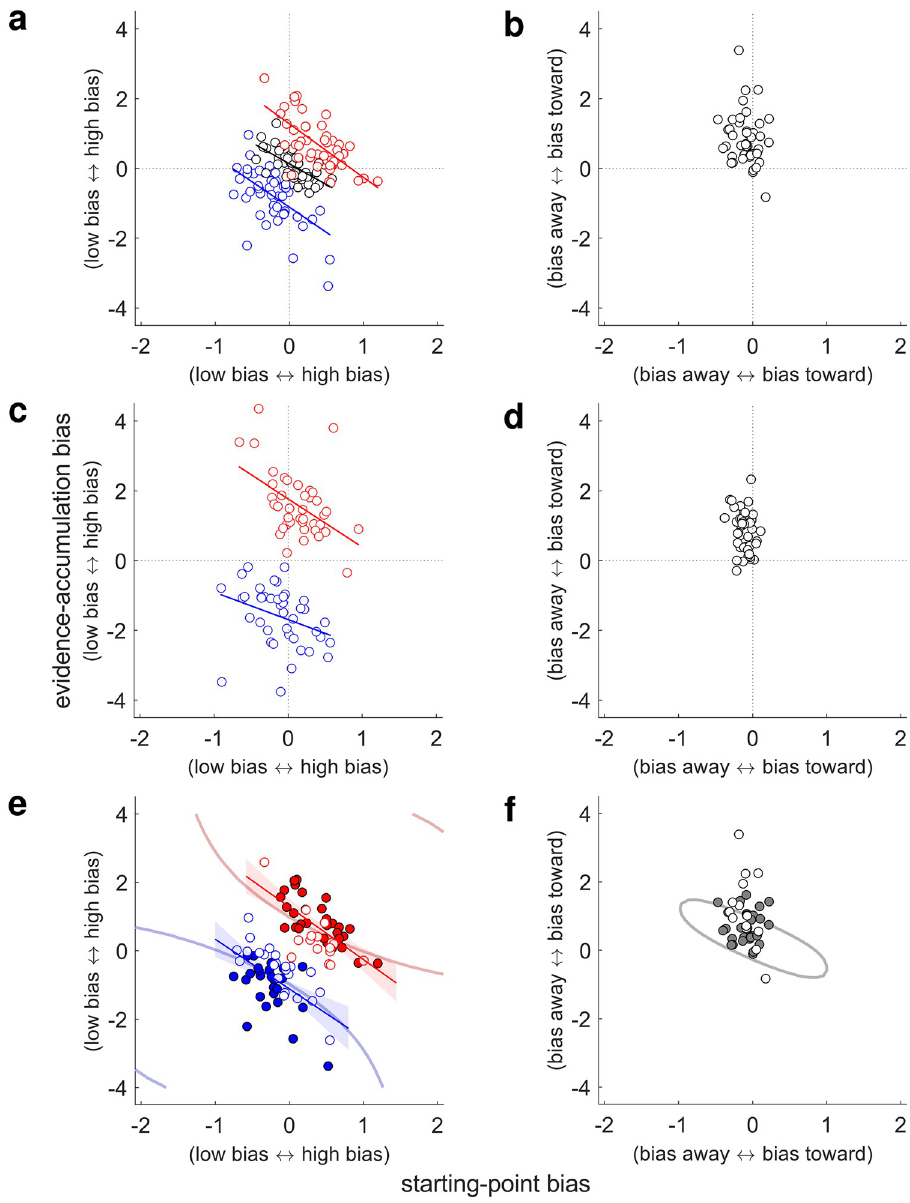
Fig 6. Different computational signatures of rule- and stimulus-based biases. Each panel shows best-fitting evidence-accumulation (ordinate) and starting-point biases (abscissa), plotted per subject (points). A Data from the rule-based condition, for each of the three prior cues (blue: low, black: neutral; red: high). Lines are linear fits ( p < 0.05). B Data from in the stimulus-based condition (no linear relationship). C Data from the rule-based biases of the mixed condition, plotted as in A . D Data from the stimulus-based biases of the mixed condition, plotted as in B (no linear relationship). C and D show results for mixed-condition 1, which included block-level prior cues; results were similar in mixed-condition 2, which had trial-wise priors. E Data from A (the low- and high-prior conditions) plotted with respect to optimal performance contours from the rule-based condition. The average 97% contours (curved lines) demarcate the area of the parameter space in which choice accuracy is at least 97% of the maximum possible accuracy. Accuracy was predicted by the DDM applied to the actual task sequences. Closed/open circles indicate that the data fell within/outside of the subject-specific 97% contour. Lines are linear fits as in A , and shaded regions are 95% confidence intervals. F Same as E , but for the stimulus-based condition. The 97% contour is for the context of two low tones before the test tone (similar results were obtained for two high tones but not